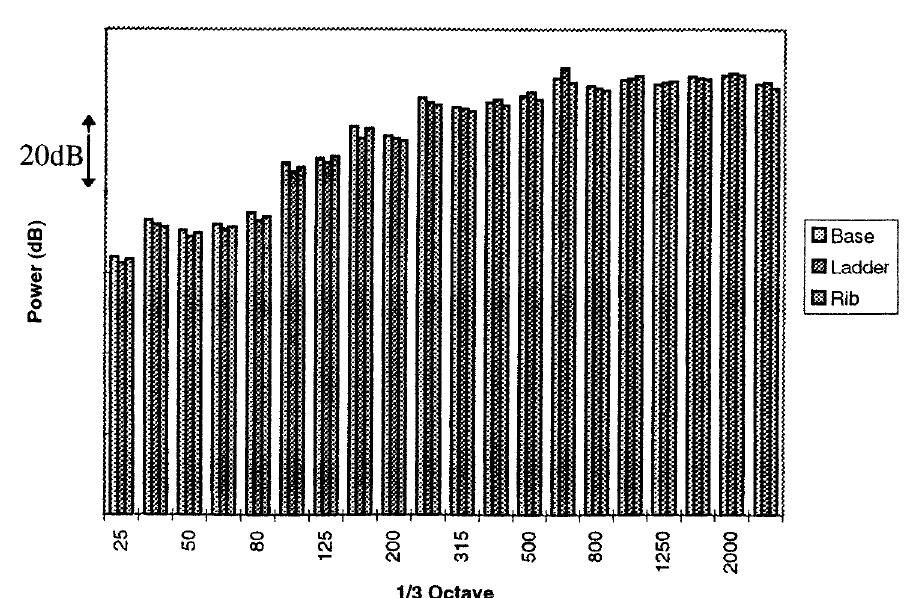
Fig. 9. Radiated sound power per 1/3 octave frequency band for three